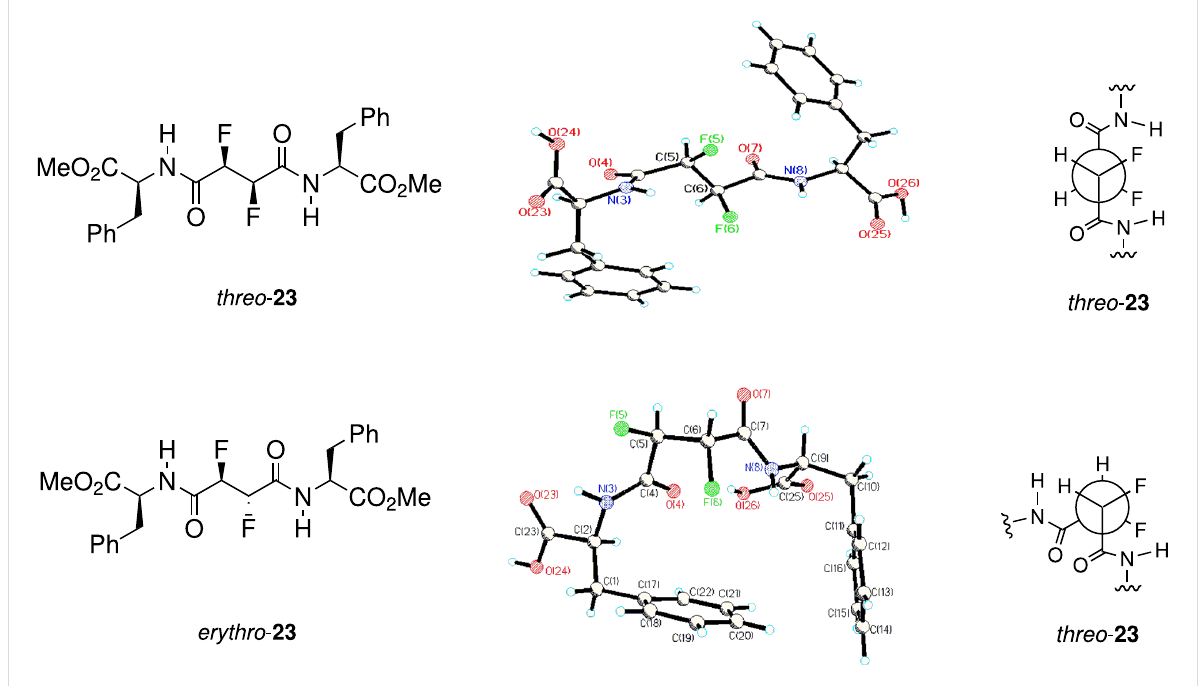
Figure 14: The conformations of erythro - and threo - 23 are very different as a consequence of each conformation preserving a vicinal fluorine gauche relationship [18].